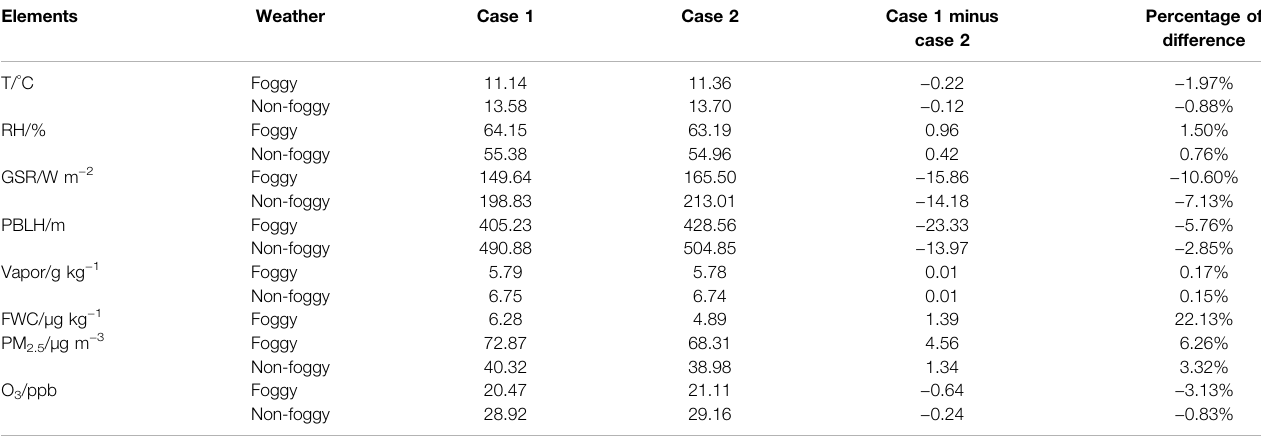
TABLE 4 | The DRE on meteorological elements and pollutants on foggy days and non-foggy days. Elements